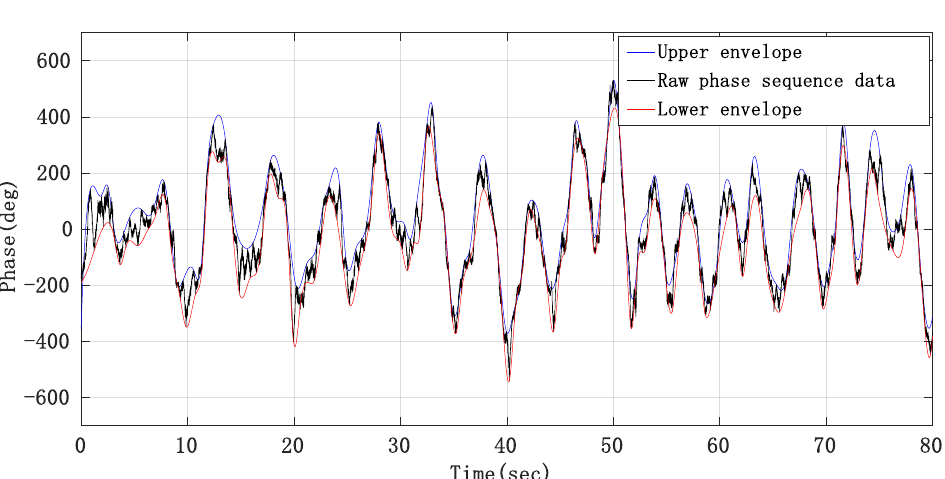
Figure 13. Schematic diagram of eliminating respiratory fundamental wave by envelope method. By subtracting the middle line of the upper and lower envelope from the raw phase sequence data, the phase signal mainly composed of the heartbeat signal, radar system noise and residual respiratory harmonics can be obtained, whose signal waveform is shown in Figure 14.